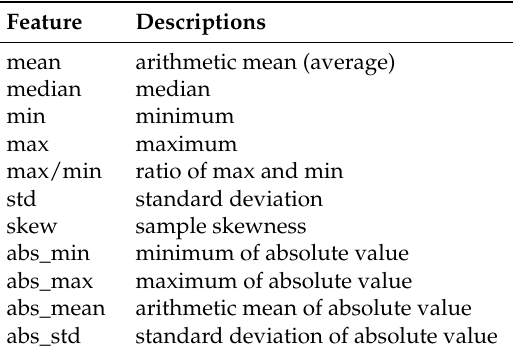
Table 1. Features explored for random forest classifier. Eleven features were calculated based on each of the three-axis acceleration